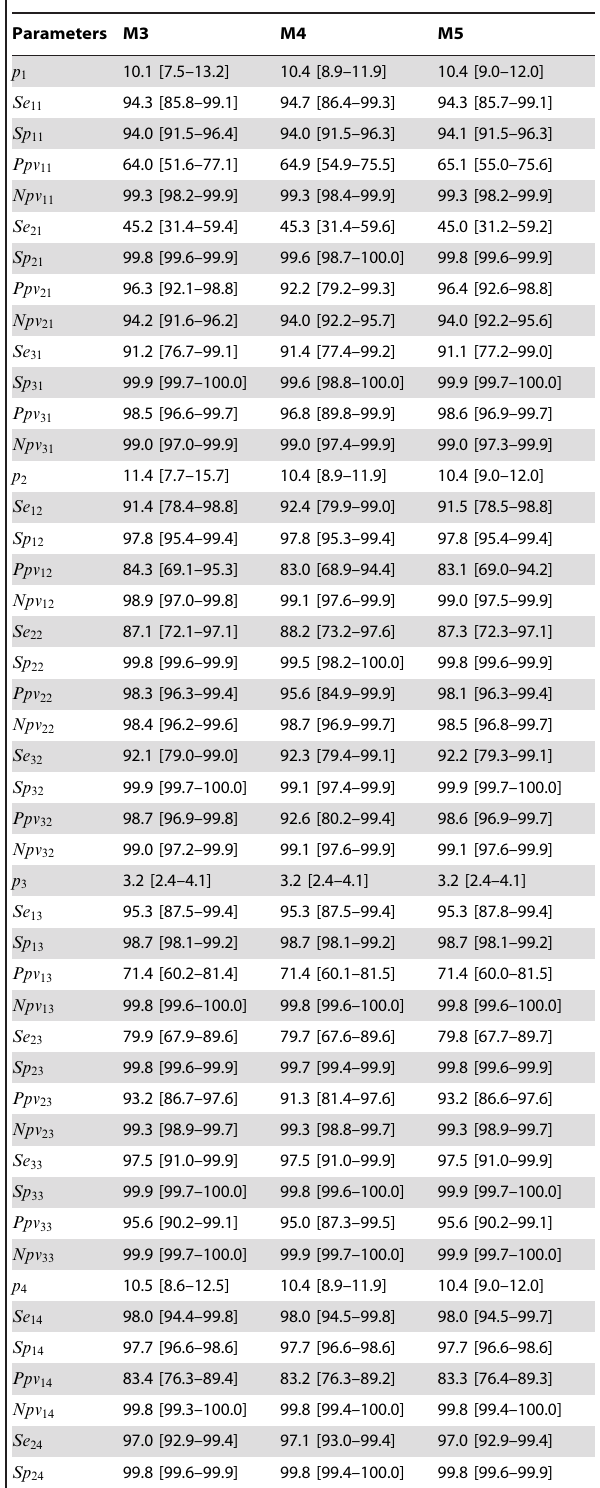
Table 4. Bayesian estimates of prevalence, sensitivities, specificities and predictive values, given by posterior means and 95% credibility intervals – Mean [ P 0 : 025 { P 0 : 975 ] – with non-informative priors, by age groups and fever status, using the models M3, M4 and